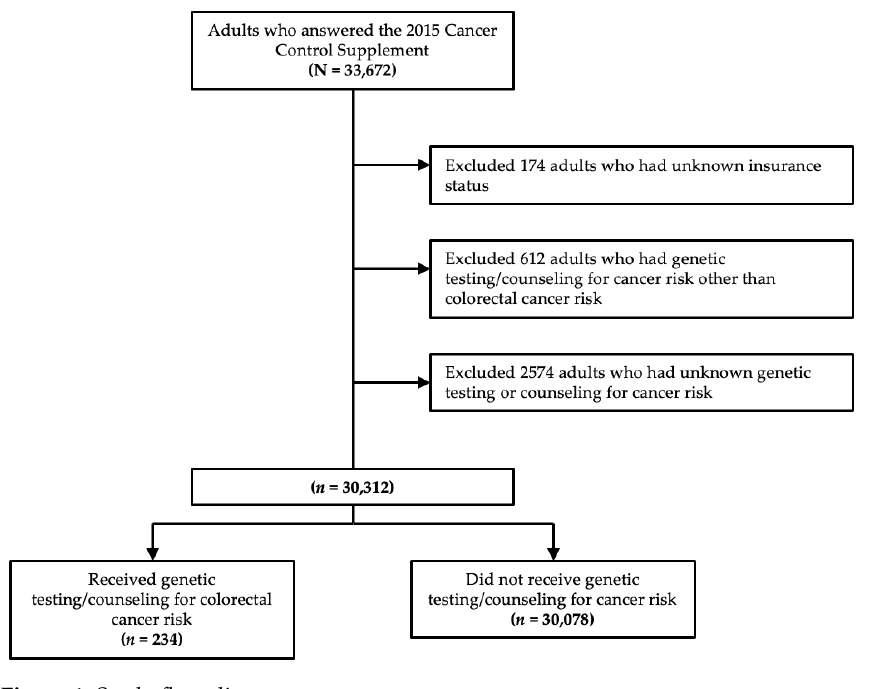
Figure 1. Study flow diagram. Table 1. Baseline Characteristics.